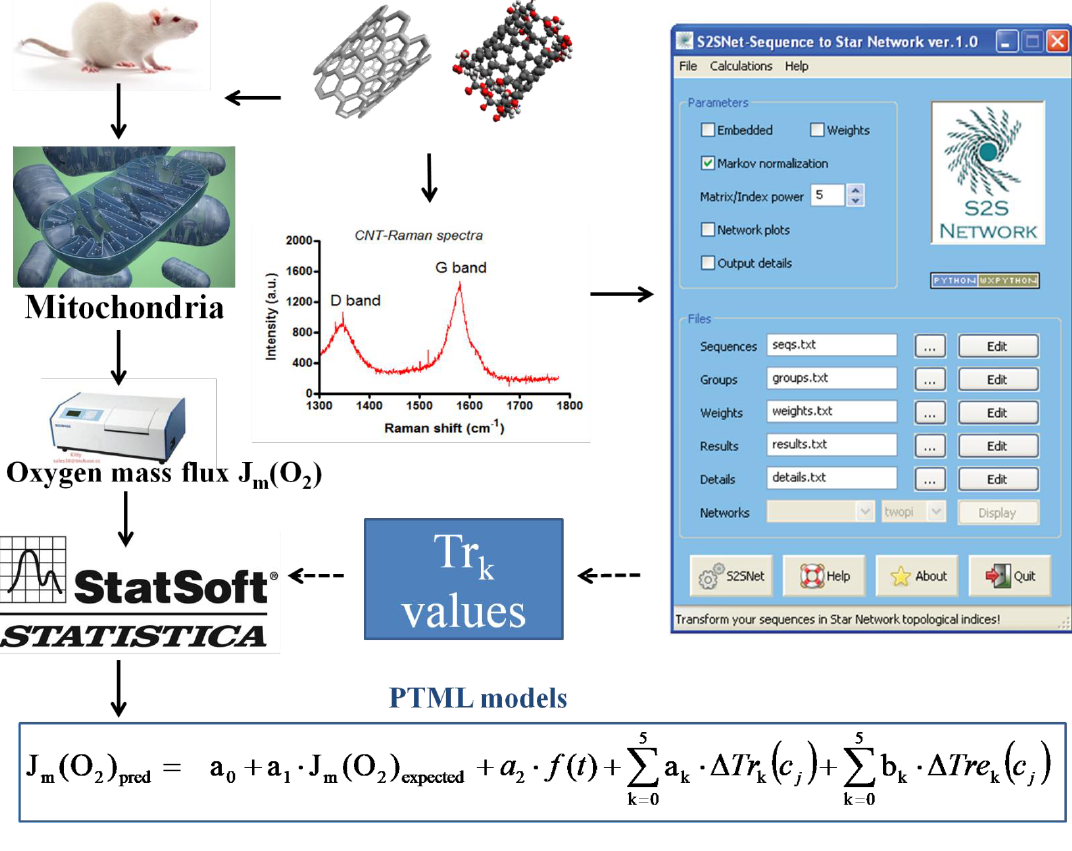
Figure 1. General workflow.